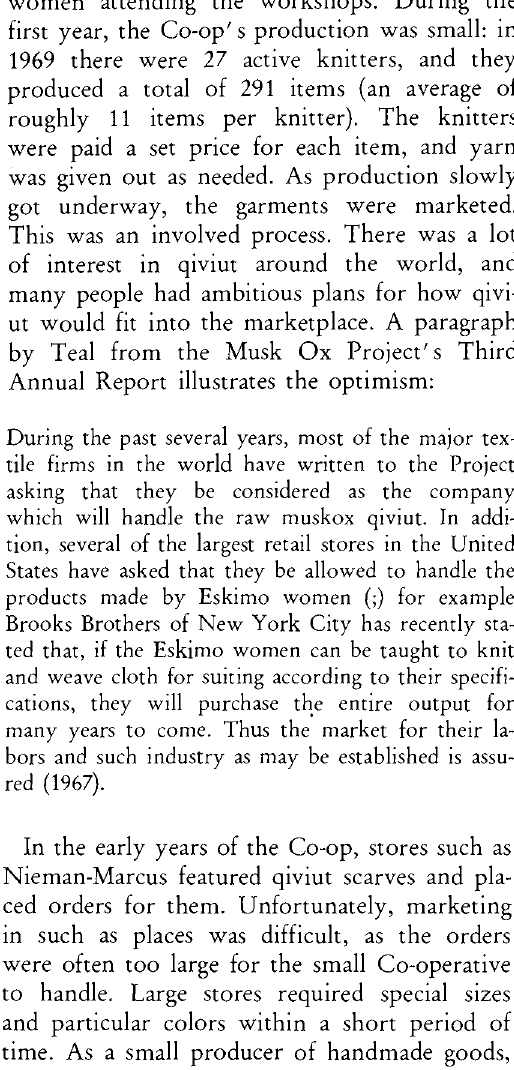
Fig. 1. Annual sales since 1977 (sales statistics before 1977